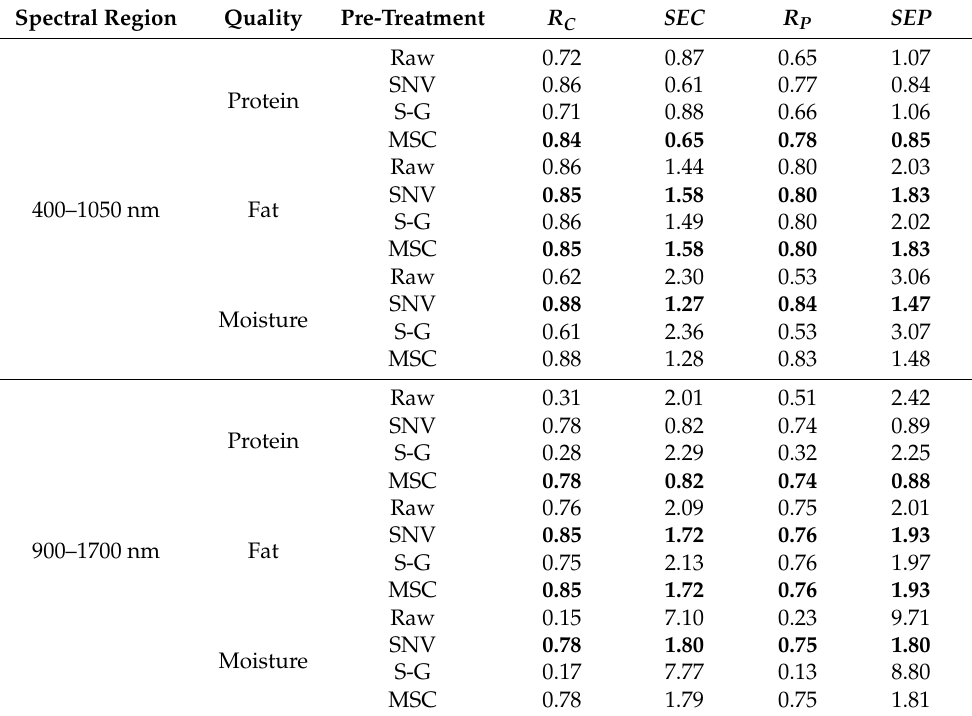
Table 2. PLSR modeling results based on raw reflective